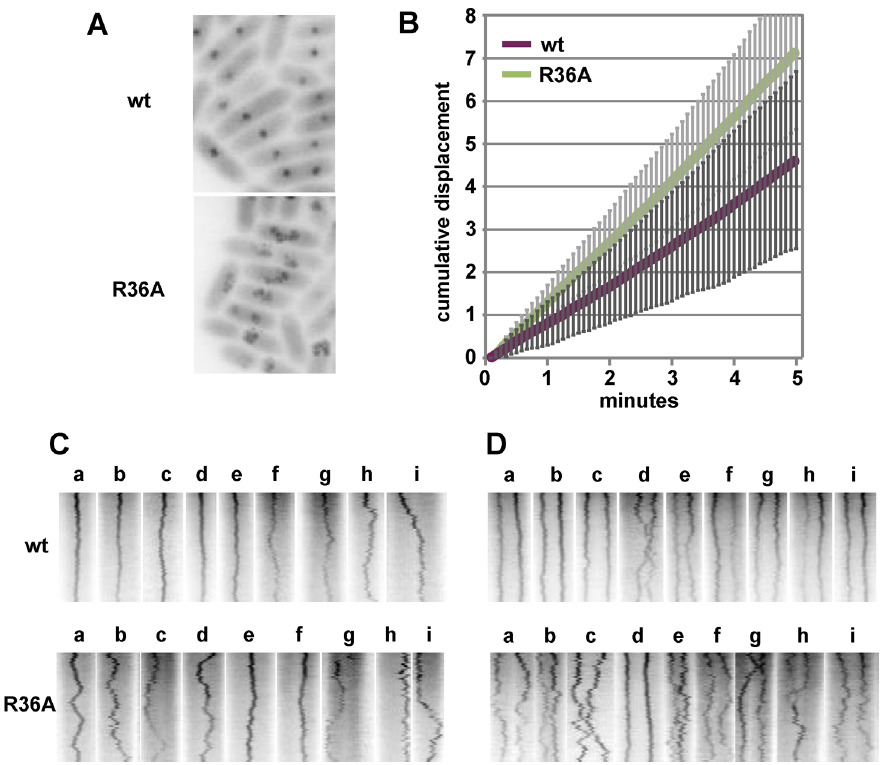
Figure 6. Effect of R36A mutation on mini-F movement. A. Cumulative displacement of mini-F, from images acquired every 5 secs for 5 mins, drawn using the Z project plug-in of Image J. B. Average cumulative displacement in 30 cells as illustrated in A; error bars are standard deviations. C. Illustrative individual kymographs of 1-focus cells; width corresponds to cell length (not equalized). D. As for C, 2-focus cells.